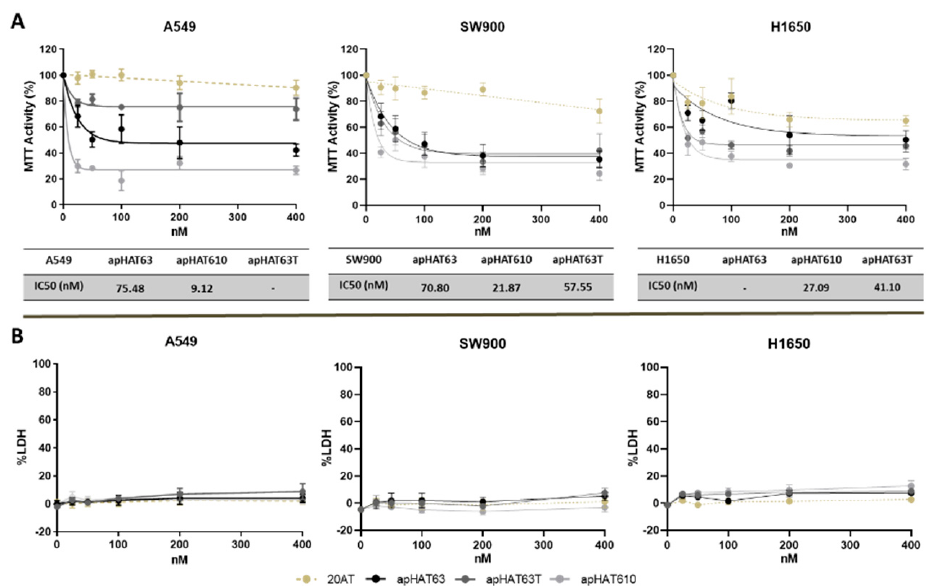
Figure 5. Effect of the aptamers on the MTT and LDH activity of lung cell lines. A549, SW900, and H1650 cells were seeded in p96 at a density of 6 × 10 3 cells/well for A549 and 10 4 cells/well for the other two lines. After 24 h, they were transfected with the different aptamers at 25, 50, 100, 200, and 400 nM, and at times of 48 h for A549, 120 h for SW900, and 96 h for H1650 activity assays. ( A ) MTT, with the calculation of the 50% inhibitory concentration (tables located at the bottom of the MTT graphs) and ( B ) LDH were performed. The graphs represent the means ± SEM of three independent